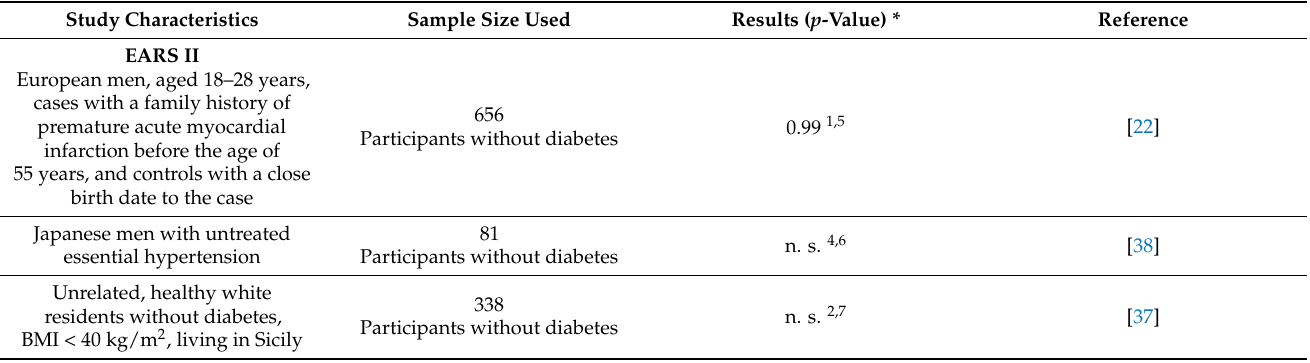
Table 2. Association between peroxisome proliferator-activated receptor gamma ( PPAR γ ) SNP rs1801282 and gAUC after an OGTT in